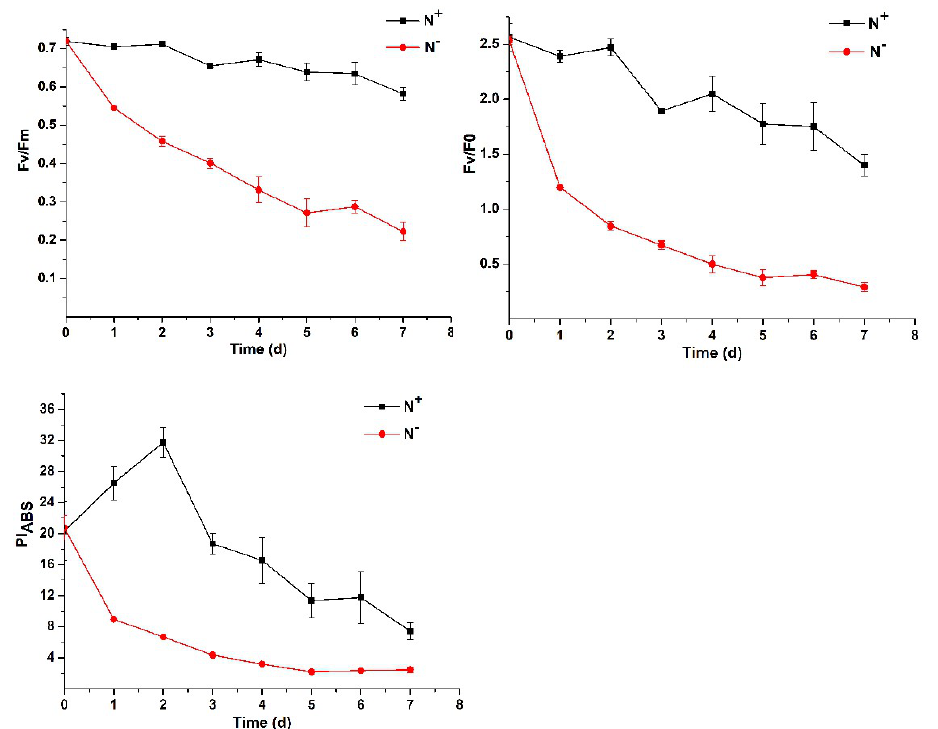
Figure 4. Comparison of chlorophyll fluorescence parameters of Parachlorella kessleri TY02 under N + and N − culture media. Data are shown as mean ± SE. n = 3.